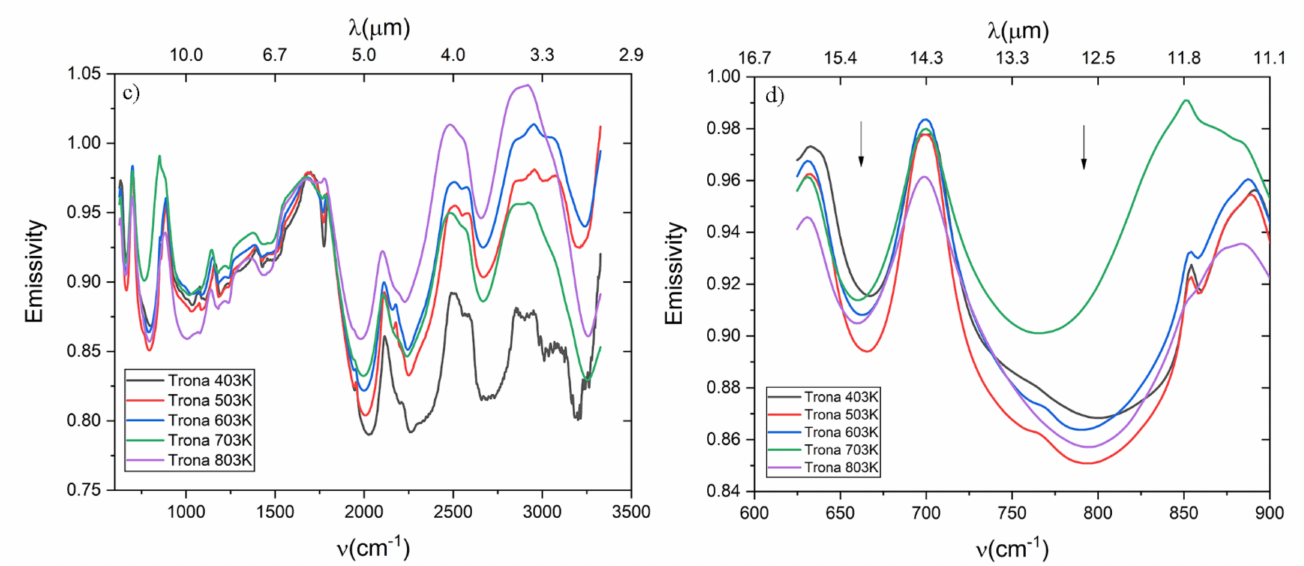
Figure 10. Reflectance spectra at room temperature and 193 K ( a , b ) and emissivity measurements from 403 to 803 K ( c ) of trona. Focus on the absorption bands cantered at ≈ 669 and ≈ 794 cm − 1 (denoted by arrows) for the emissivity spectra of the sample defined trona